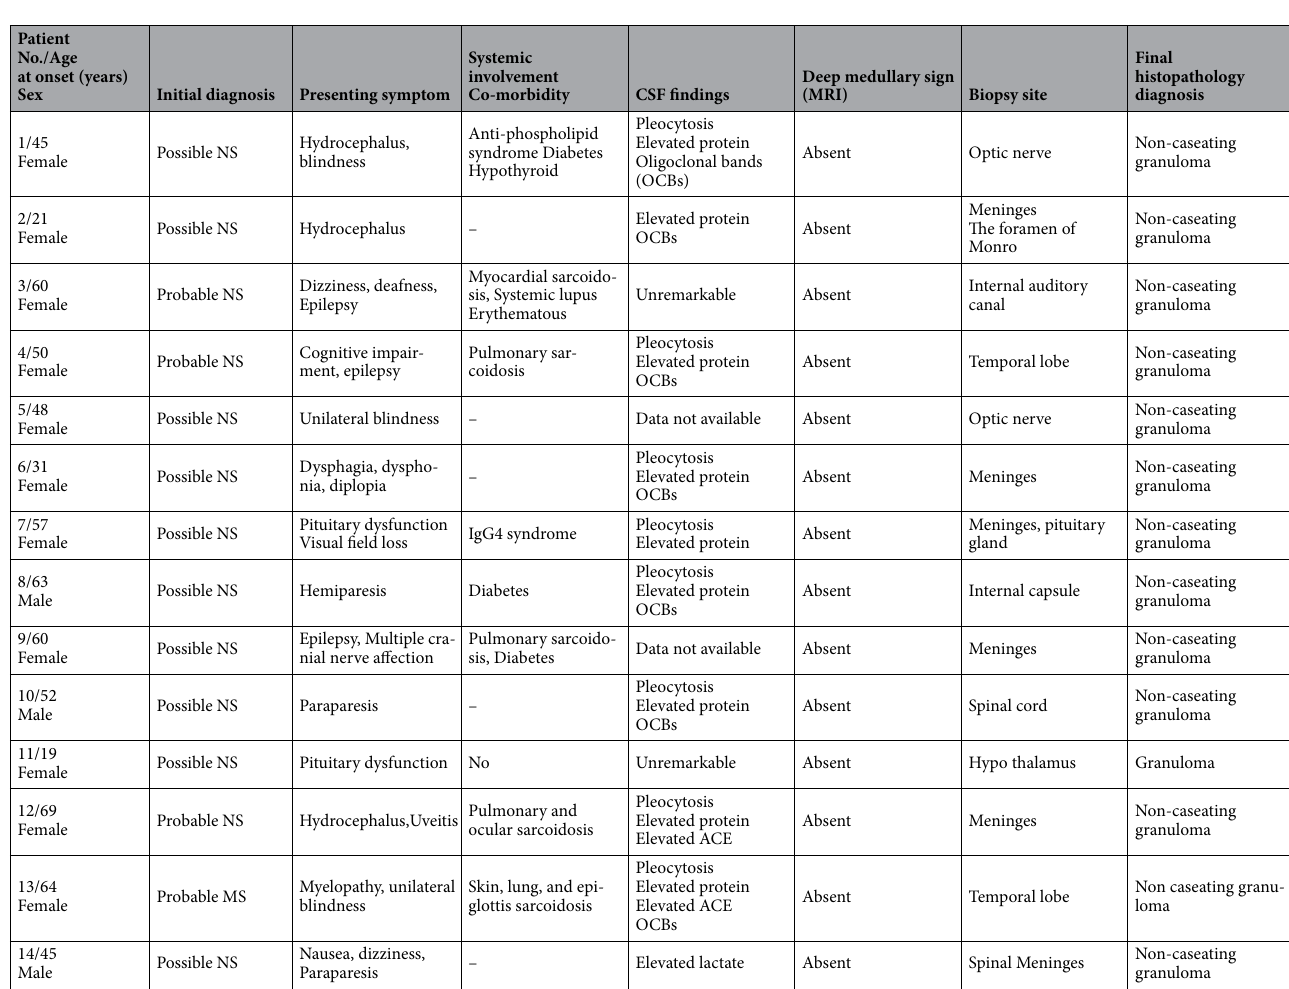
Table 5. Demographic, clinical, and CNS biopsy findings in patients with definitive neurosarcoidosis (n =